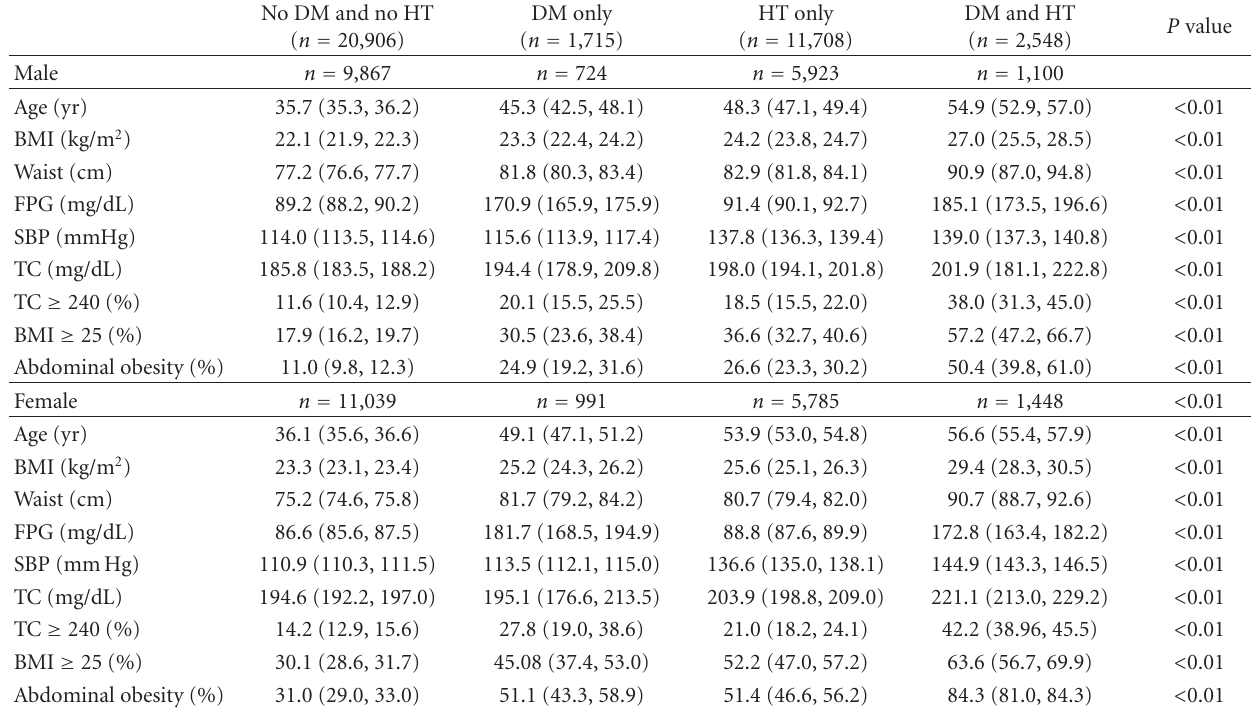
Table 1: Characteristics of participants with diabetes, hypertension and coexistence of both conditions in Thai population aged ≥ 15 years,